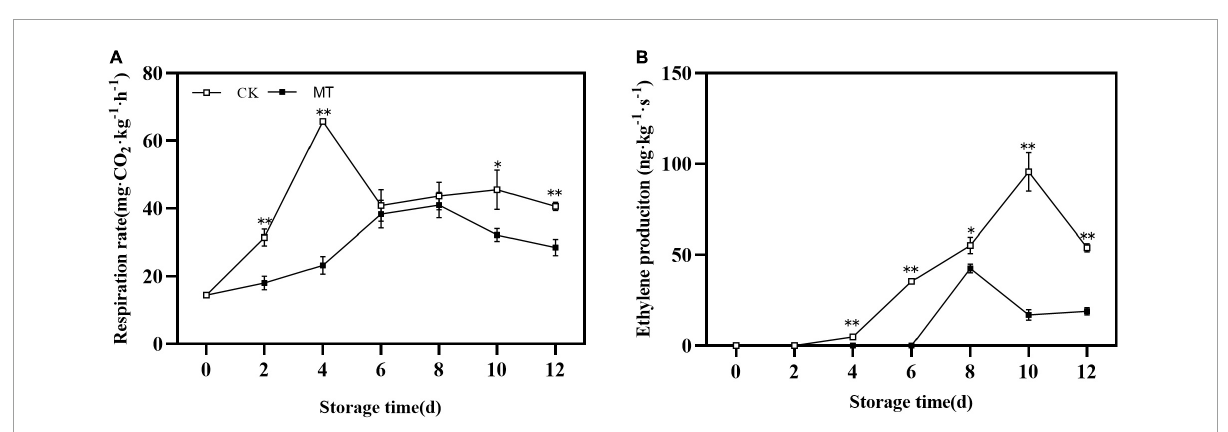
FIGURE2 Effects of melatonin (MT) treatment on respiration rate (A) and ethylene production (B) of ‘Jinyan’ kiwifruit. Data are presented as the means ± SE ( n = 3). Asterisks indicate significant differences between the control and MT treatments ( ∗ P < 0.05; ∗∗ P <